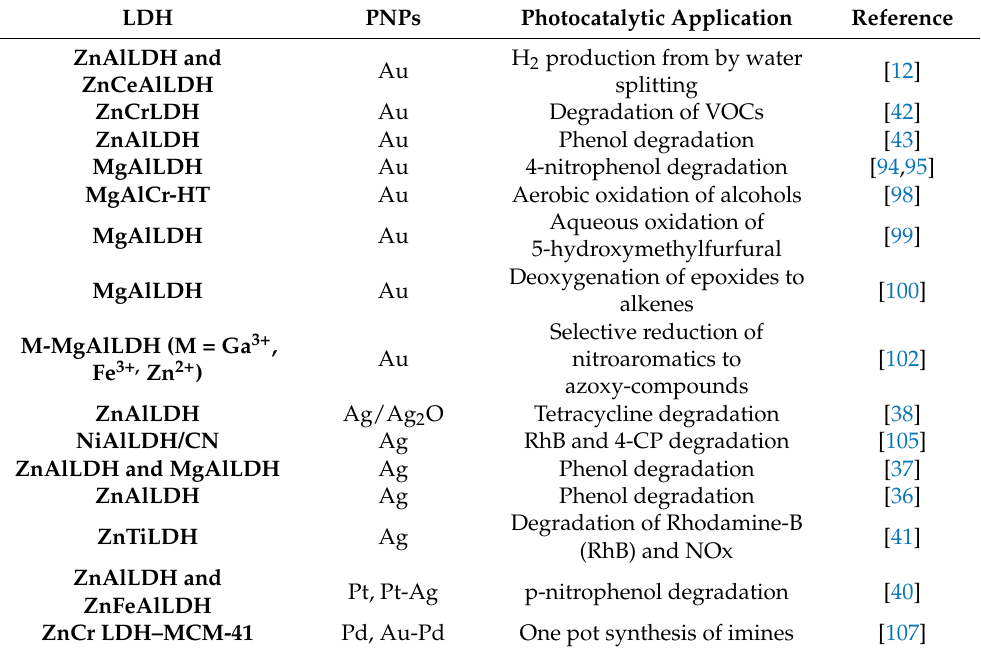
Table 1. Plasmonic noble metals/LDH heterostructures for photocatalytic